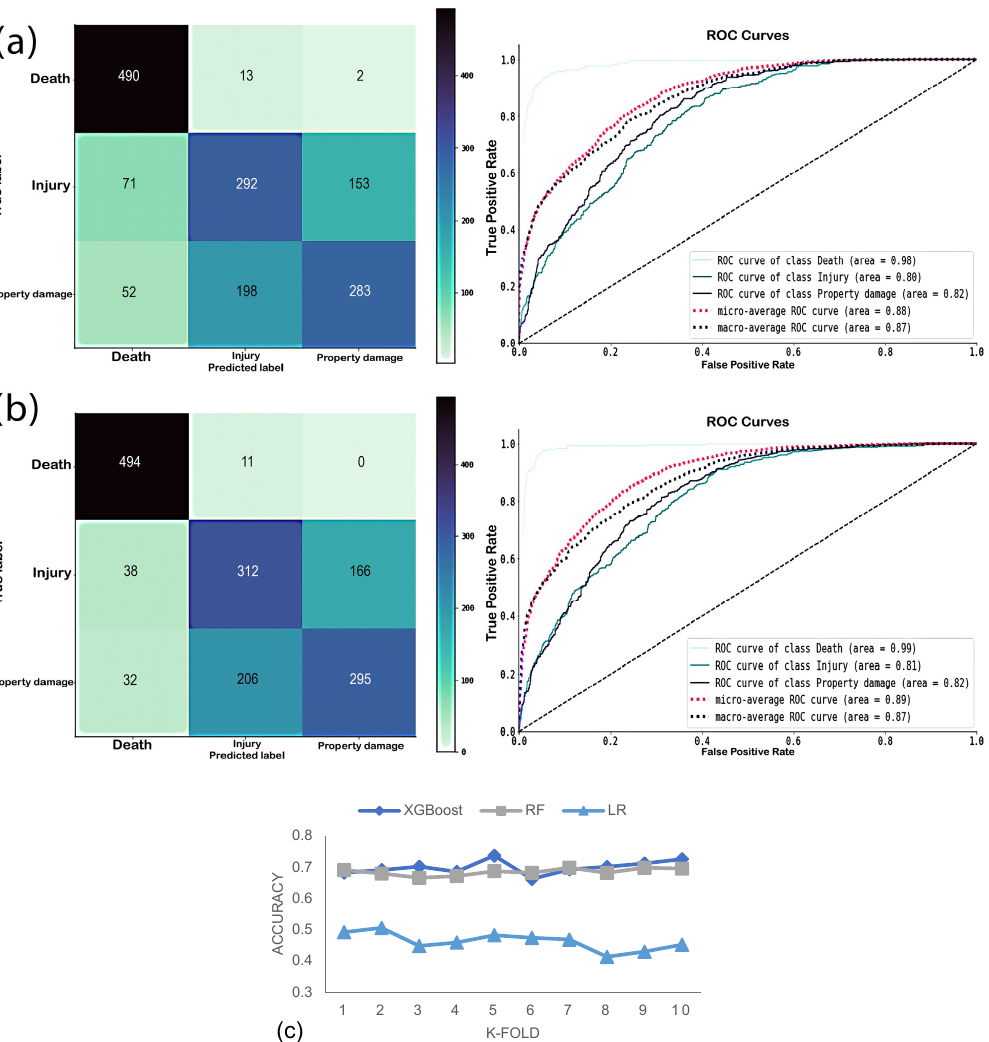
Figure 5. Multi-class model confusion matrix and ROC curves: ( a ) XGBoost model; ( b ) random forest model; ( c ) classifier accuracies by 10-fold multi-class.